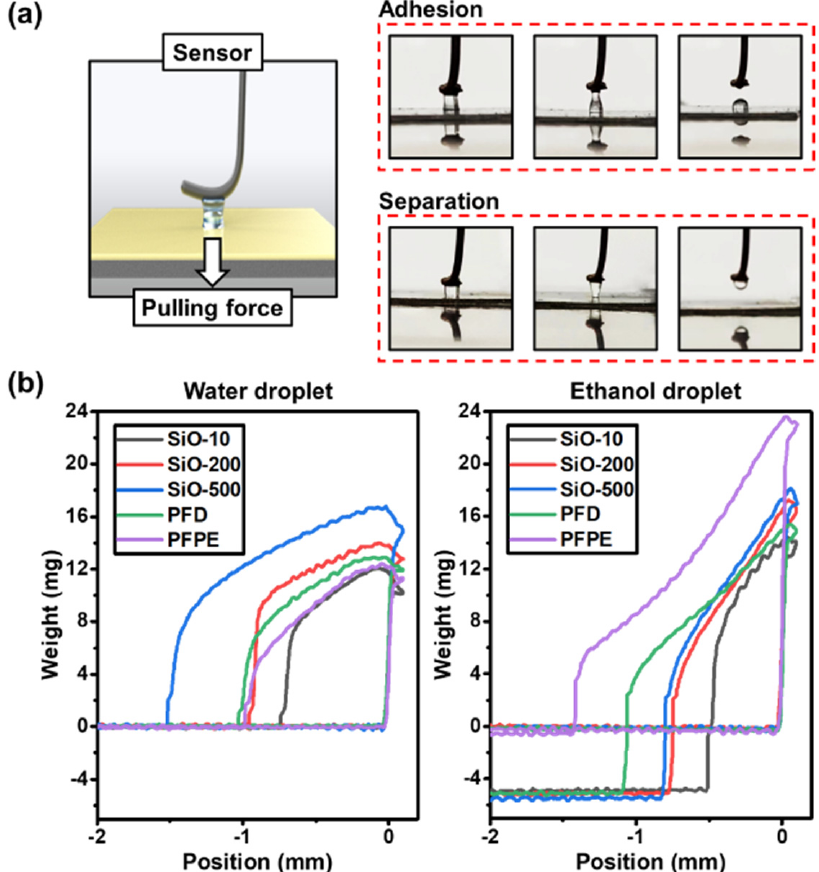
Figure 3. Droplet adhesion force tested with water and ethanol: ( a ) Adhesion and separation occurred between the droplet and the surface. ( b ) Droplet adhesion of water and ethanol on the prepared samples tested using high-precision sensors.